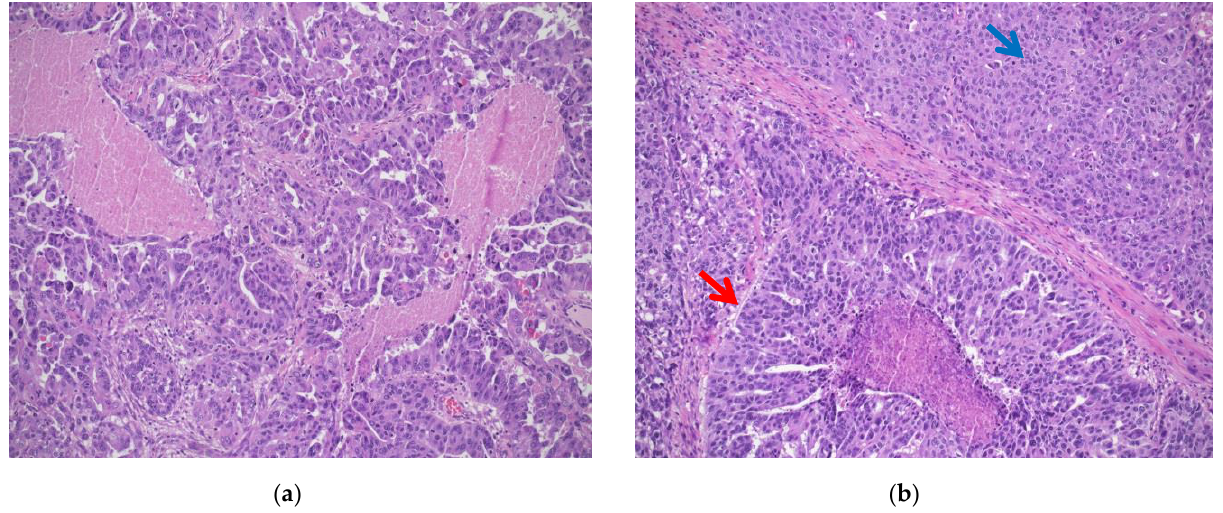
Figure 1. ( a ) High-grade serous carcinoma, classic histology. Papillary and micropapillary architecture with marked cytological atypia, atypical mitoses, and tumor necrosis (hematoxylin-eosin; × 100); ( b ) high-grade serous carcinoma, SET variant, with pseudoglandular (red arrow) and solid (blue arrow) architectural patterns (hematoxylin-eosin; × 100).